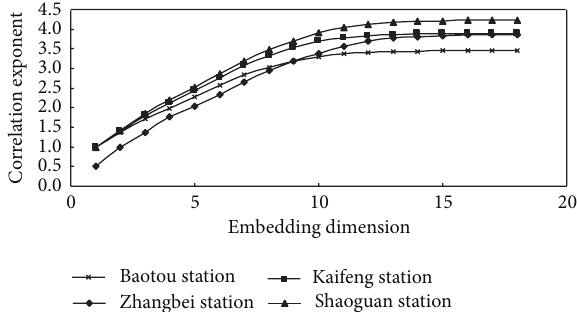
Figure 6: Relationship between correlation exponent and embed- ding dimension for daily reference evapotranspiration